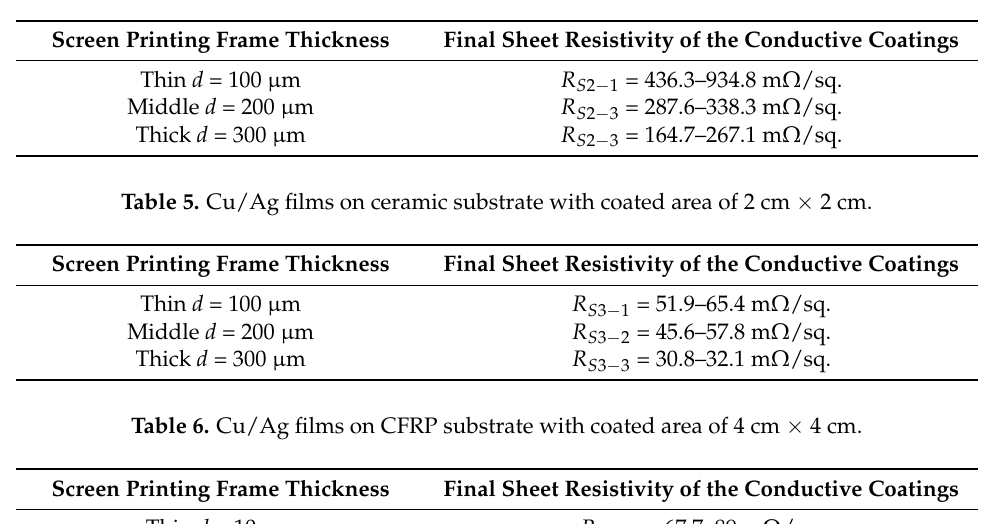
Table 4. Glass/Ag films on ceramic substrate with coated area of 4 cm × 4 cm.